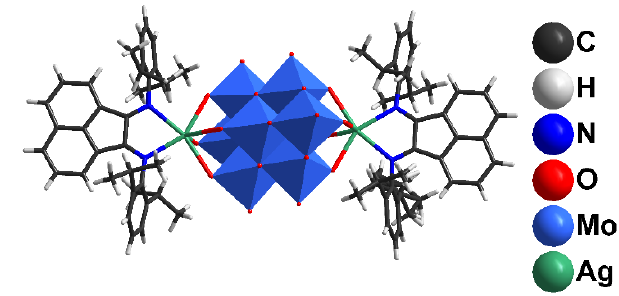
Figure 1. The structure of [β -{Ag(dpp-bian)} 2 Mo 8 O 26 ] 2 −